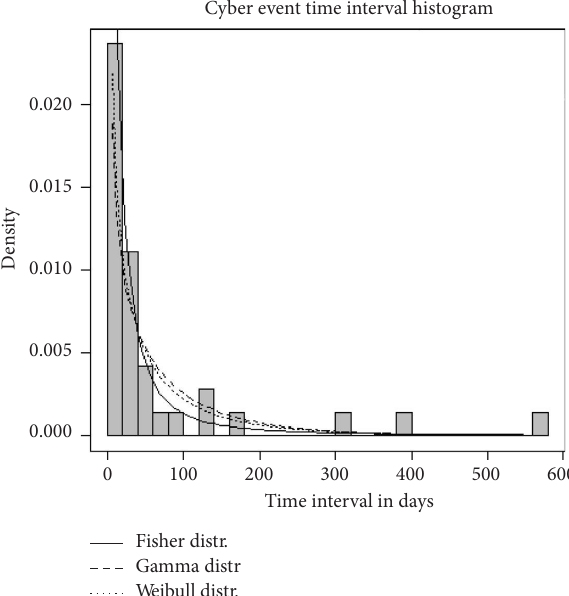
Figure 11: Cyber data breach loss frequency histogram and its assumed